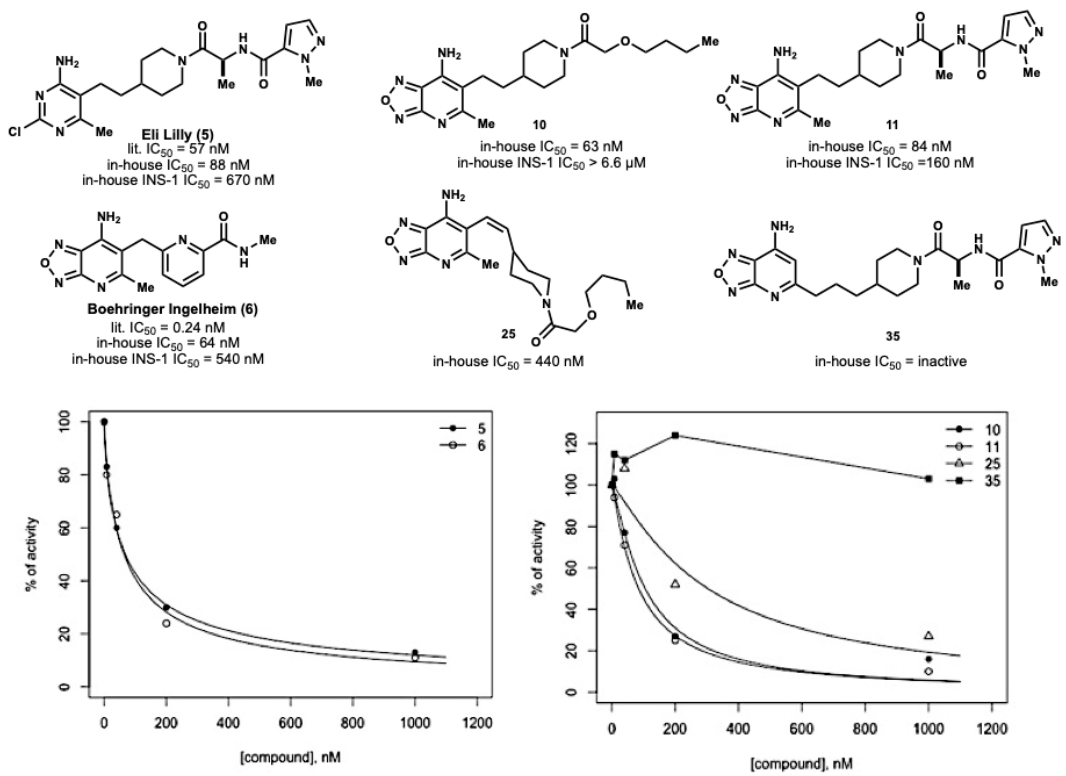
Figure 3. ( top ) In vitro and cellular activities of heterocyclic analogues (see Materials and Methods for assay descriptions); ( bottom ) In vitro inhibition of proghrelin octanoylation mediated by GOAT using the shown compounds. The experimental data was fit to a 4-parameter logistic model, (Bottom − Top)/(1 + (I/IC 50 ) n ) + Top [24] using DYNAFIT software [25]. The Top was defined as reaction conditions without inhibitor and the Bottom was defined as reaction conditions with full inhibition by 5 µM concentration of 2 . Top and Bottom conditions were included in every experiment.